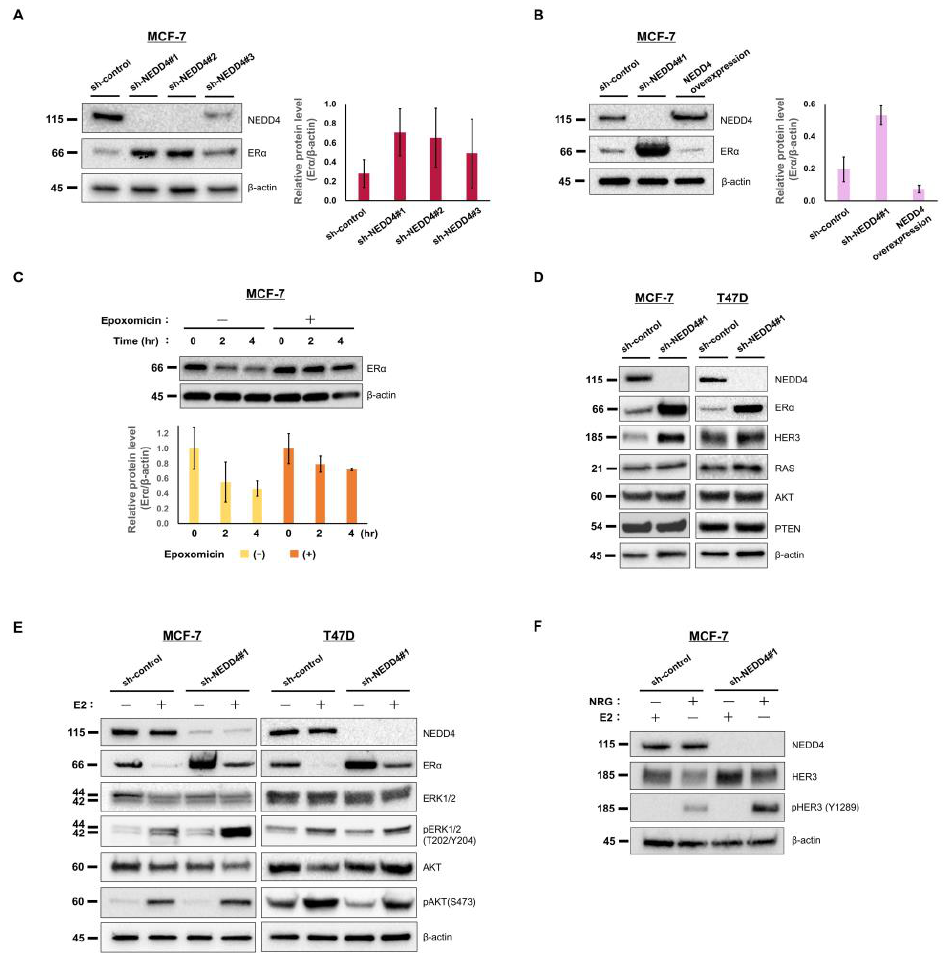
Figure 3. NEDD4 knockdown increased the expression level of ER α and the E2-stimulated phospho- rylation of ERK1/2. Whole cell lysates of MCF − 7 and T47D cells were subjected to Western blotting. Parts of the full Western blots were cut out and used for the Figure. The original images of the Western blots are shown in the Supplementary Materials: Figure S6–S12 and S14 ( A ) NEDD4 was knocked down with shRNAs with different sequences (sh-NEDD4#1, sh-NEDD4#2, and sh-NEDD4#3). Sh- NEDD4#1 and sh-NEDD4#2 cells showed no expression of NEDD4 and a high expression of ER α . ( B ) MCF − 7 cells overexpressing NEDD4 showed a decrease in the expression of ER α . ( C ) Epoxomicin (5 µ M) delayed the degradation of ER α in the MCF − 7 cell line. ( D ) Expression levels of NEDD4 and proteins associated with NEDD4 in sh-control and sh-NEDD4#1-knockdown cells. Western blotting showed no expression of NEDD4 and a high expression of ER α and HER3 in the sh-NEDD4#1 cells. ( E ) Western blotting of MCF − 7 and T47D cells stimulated with 1 nM E2 showed degradation of ER α . Phosphorylation of ERK1/2 (pERK1/2 [T202/Y204]) and AKT (pAKT [S473]) stimulated by 1 nM E2 was observed in the sh-control and sh-NEDD4#1 cells. The phosphorylation of ERK1/2 in the sh-NEDD4#1 MCF − 7 cells was greater than that of the sh-control cells. ( F ) Stimulation with 0.4 ng/mL NRG led to the phosphorylation of HER3 (pHER3 [Y1289]), but not with 1 nM